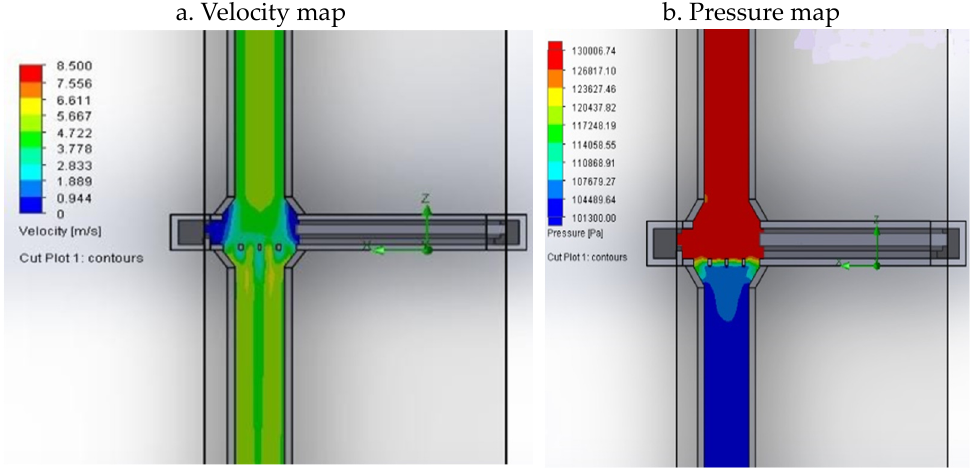
Figure 22. Third valve geometry with 100% opening.